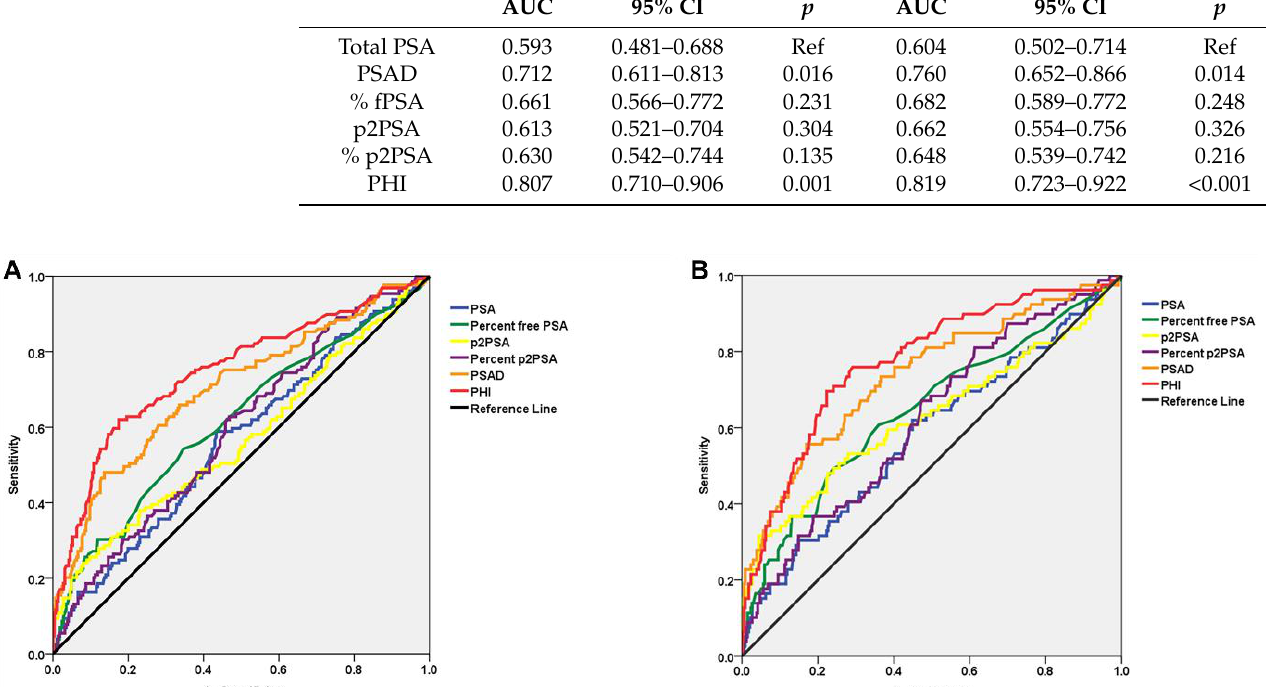
Figure 3. Receiver operating characteristic (ROC) curve analysis for PSA derivatives for the prediction of ( A ) overall prostate cancer and ( B ) clinically significant prostate cancer.